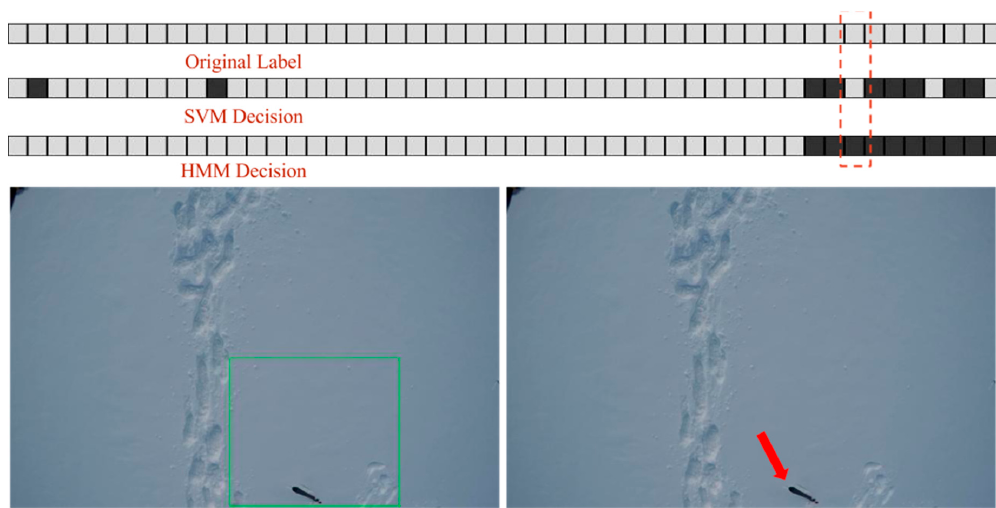
a black square indicates the opposite. The frame where the change happened is outlined by a red dotted rectangle and the corresponding frame in the bottom. The frame for which SVM made a wrong decision is shown in the bottom left (the object in the frame, skis in this case, is indicated by a red arrow), whereas the same frame corrected by HMM is shown in the bottom right (the object in the frame is indicated by a green arrow). Note that the object is not localized since a post-processing decision is made at the frame level.